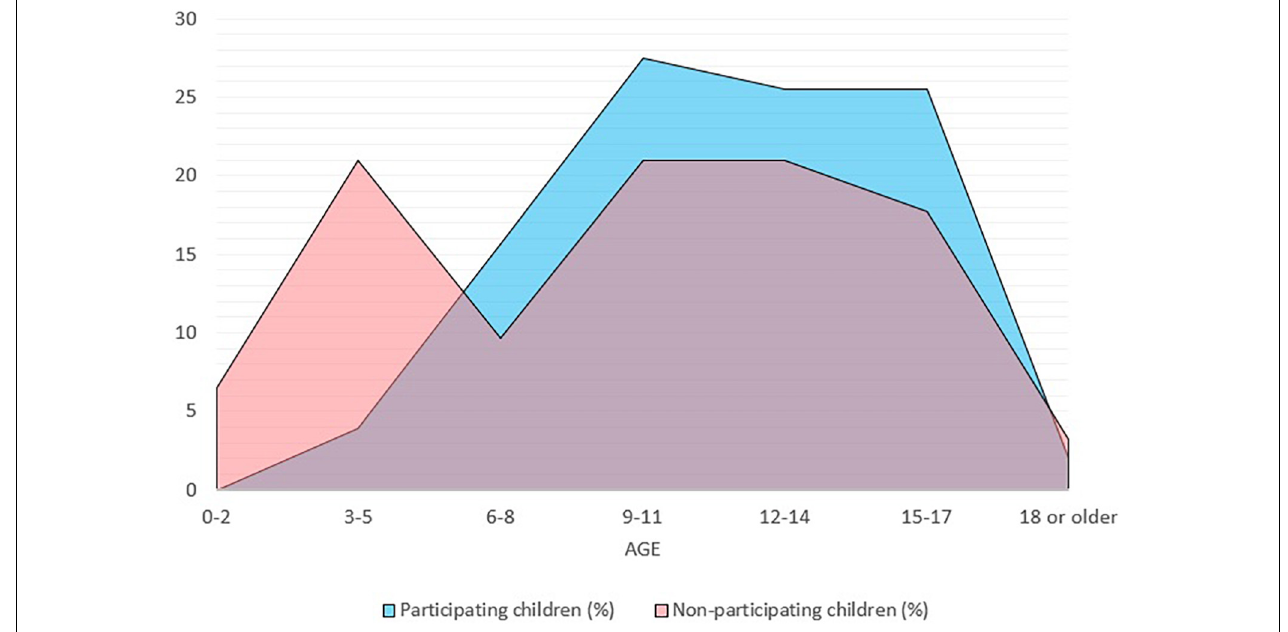
FIGURE 2 | Age distribution for participating and non-participating children. n = 113, age missing for 11 participating children and 33 non-participating children.